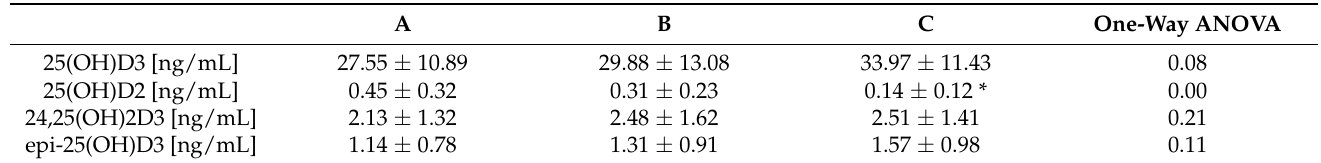
Table 1. Vitamin D metabolites results were measured at all sampling points.